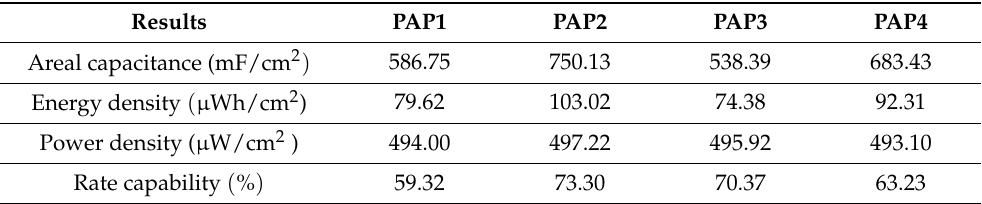
Figure 13. ( a ) Ragone plots of all supercapacitors and ( b ) Plot of rate capability against the current density. Table 2. The maximum performance properties obtained by the developed